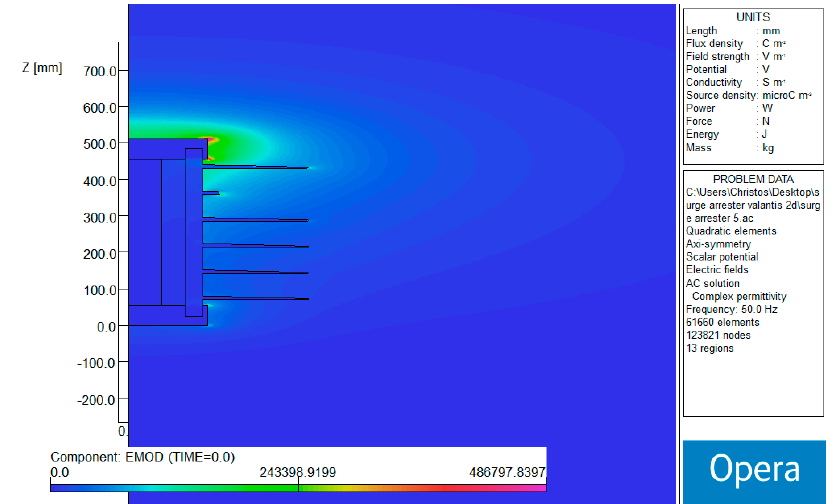
Figure 14. Electric field around the arrester in the case of a broken shed (2D PC Opera).